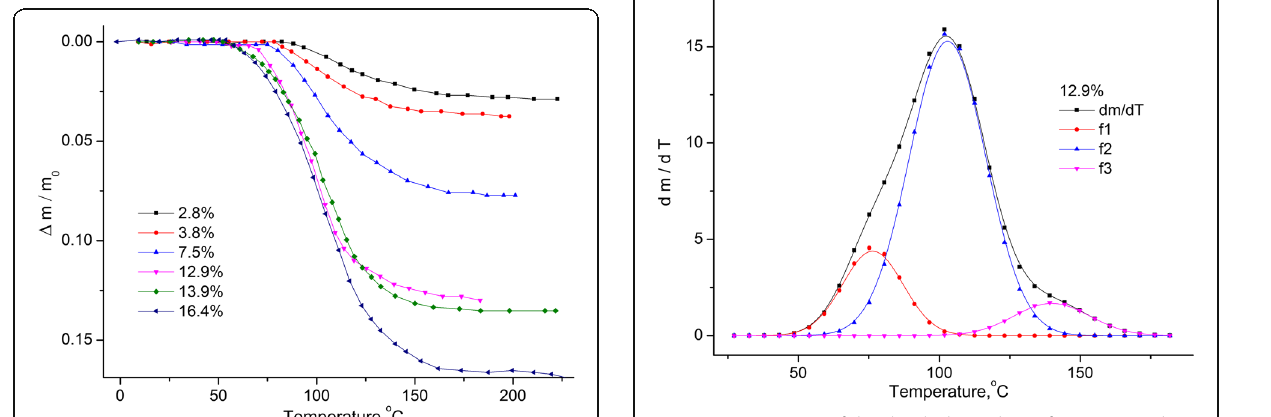
Fig. 3 Approximation of the dm / dT dependence for MCC sample with the humidity of 12.9%. Approximation of the dm / dT dependence for MCC sample with the humidity of 12.9% using Gauss distribution with three